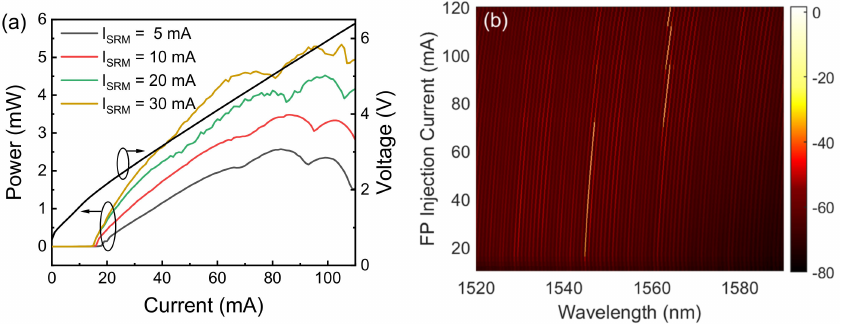
Figure 3. ( a ) The voltage and SMF coupled power versus FP cavity CW injection current with fixed SRM currents of 5, 10, 20, and 30 mA, respectively. ( b ) The lasing spectra when the SRM injection current is fixed at 10 mA and FP cavity injection current versus from 10 mA to 120